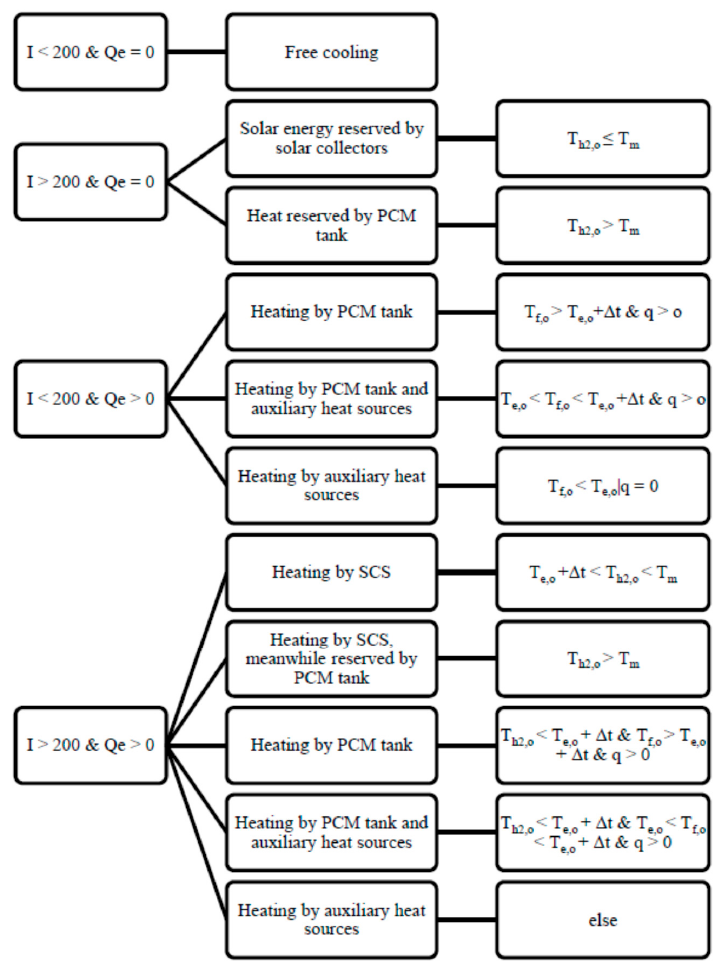
Figure 2. Control strategy of the SHS-PCM.